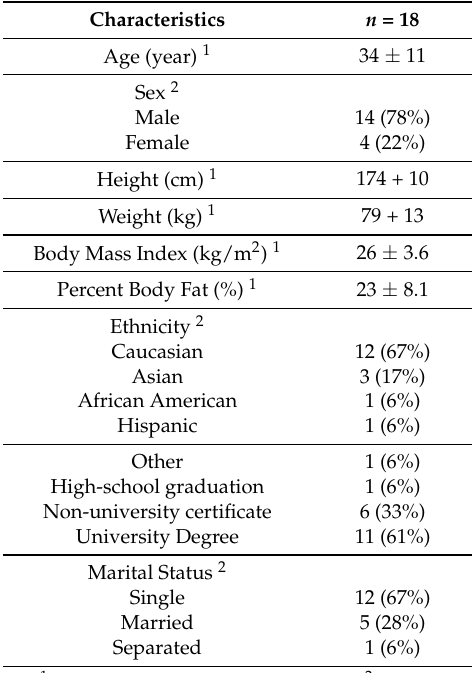
Table 1. Characteristics (demographics and anthropometrics) of the study